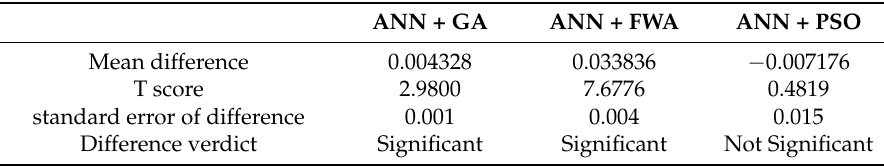
Table 9. Statistical test of RNA-Seq between ANN and the three algorithms GA, FWA, and